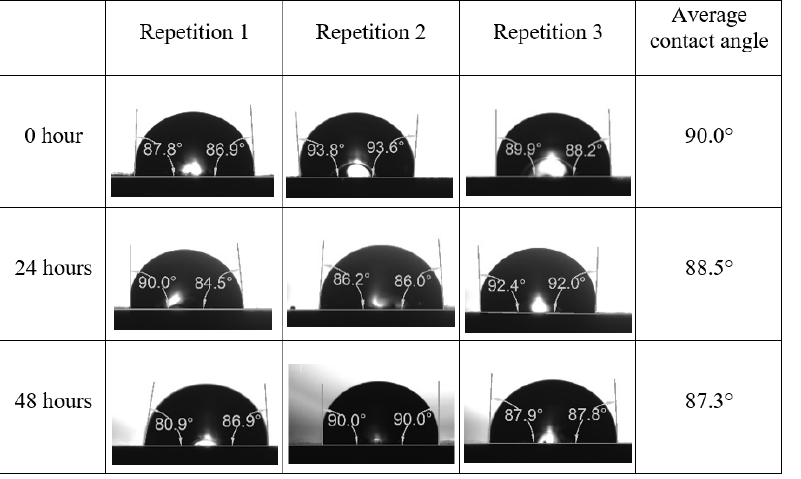
Figure A7. Dynamic Contact Angle Measurement Results for 25% MgCl 2 + 75% KCl (3500 ppm).